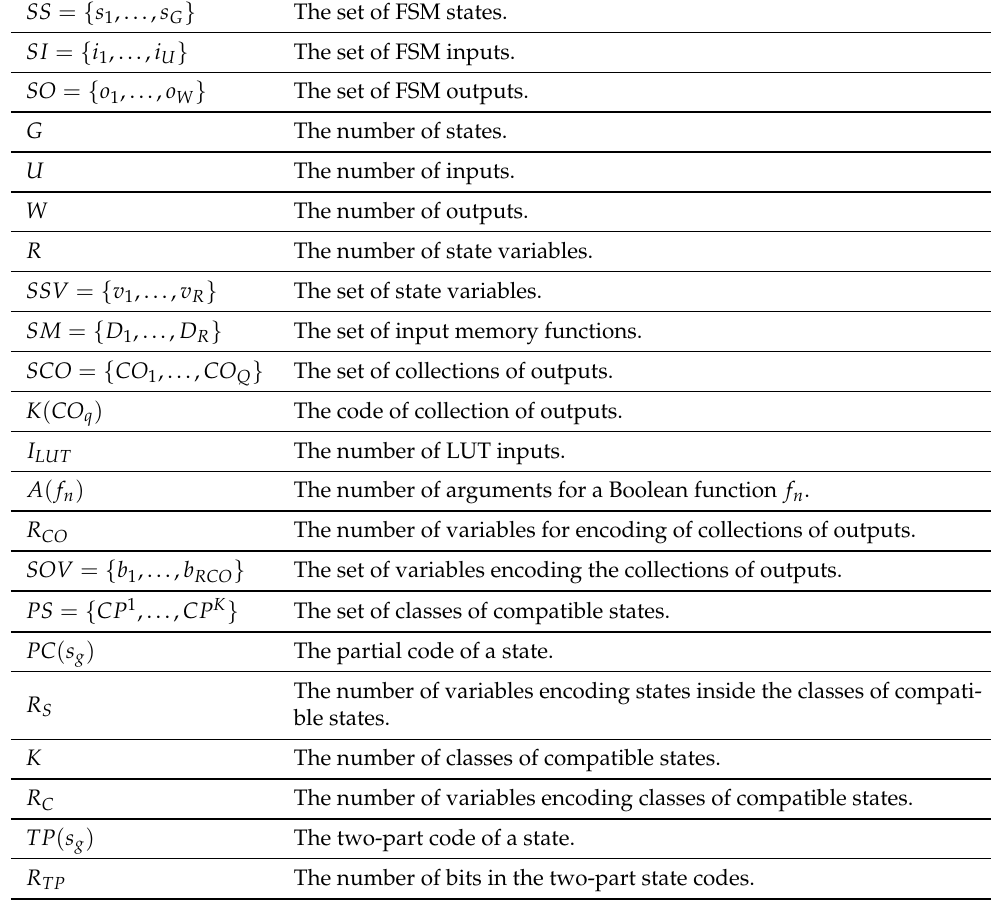
Table 1. The main